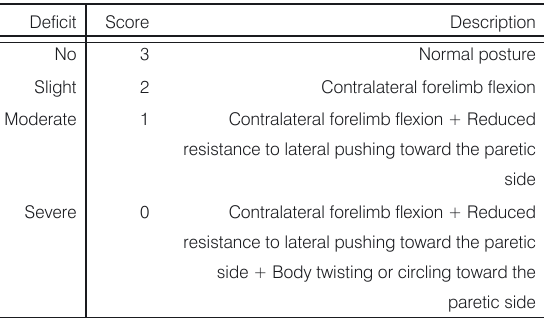
Table 1. Neurological deficit scoring in posture reflex/hang test. Table 2. Experimental